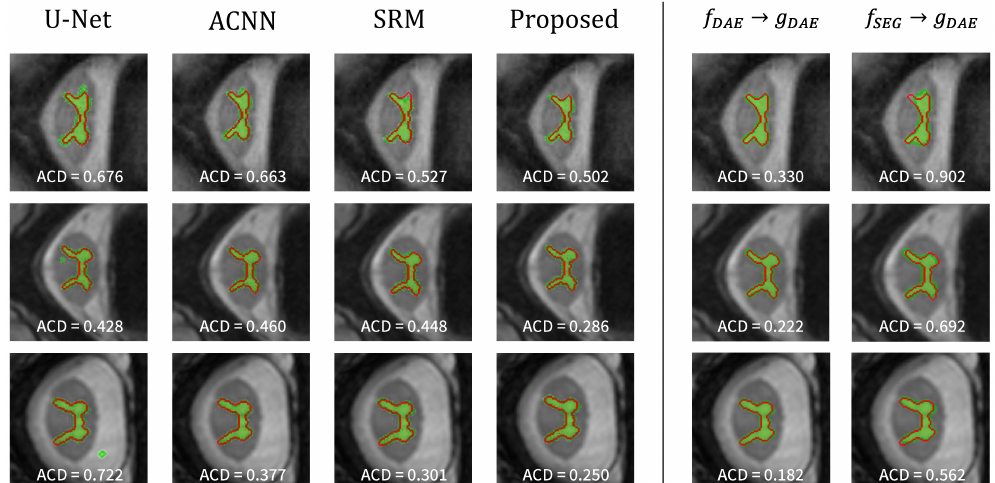
Figure 5. Visualization of the spinal cord segmentation results on test samples from site2 ( top ), site3 ( middle ), and site4 ( bottom ). The left part shows the results of each method, and the right part presents the results from f DAE → g DAE and f SEG → g DAE of the proposed method. The green color represents the segmentation results of each method, and the ground-truth is in red.